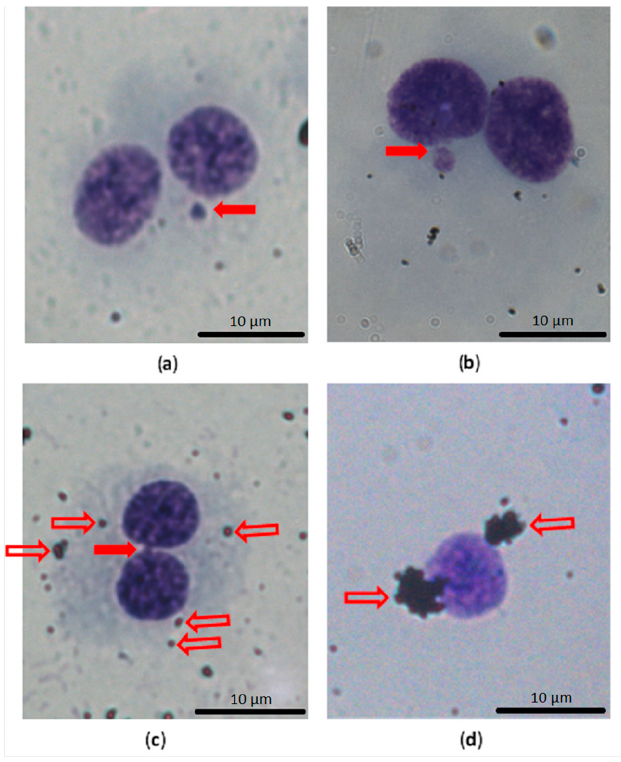
Figure 6. Example of the main assessed findings in CBMN test, with a comparison of the nucleus with cytoplasm and naked nucleus and GP clusters. ( a ) Binucleated cell (BNC) with one micronucleus (solid arrow); ( b ) BNC with a nuclear bud connected with the main nucleus by a narrow bridge (solid arrow); ( c ) BNC with a nucleoplasmic bridge (solid arrow) and small agglomerates of GP in the cytoplasm (on the cell surface; outline arrows); ( d ) naked nuclei without cytoplasm in the CBMN test were more often surrounded by clusters of GP (outline arrows).